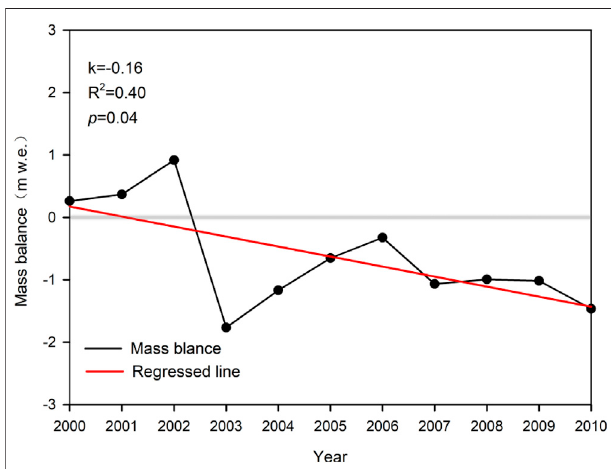
FIGURE 3 | Changes in the mass balance of the Baishui River Glacier No. 1 from 2000 to